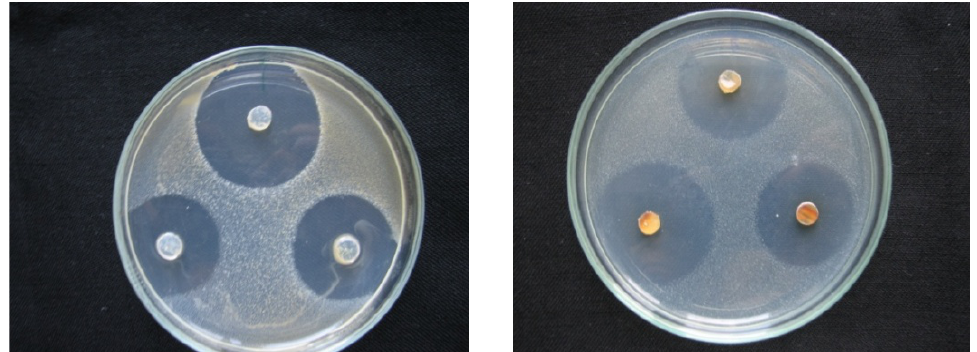
Figure 2. The classification of actinomycetes from extreme ecosystems into groups and subgroups